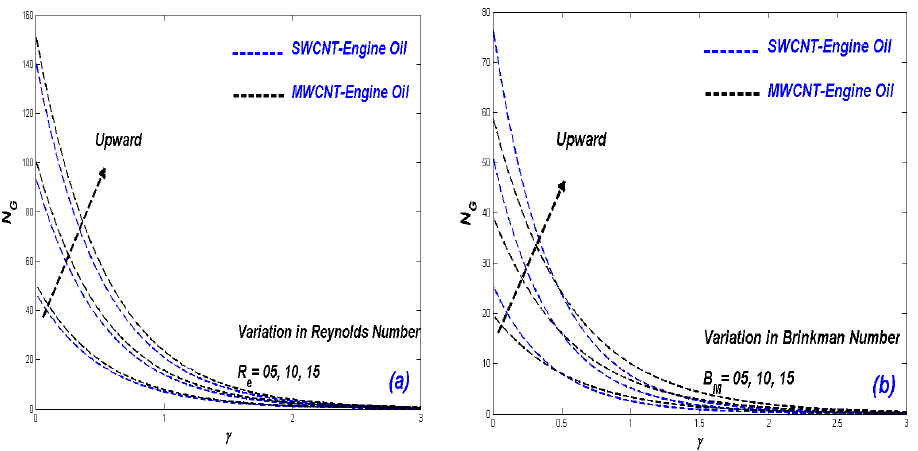
Figure 13. ( a ) Entropy changes with 𝑅 (cid:3032) ; ( b ) Entropy change with 𝐵 (cid:3014)